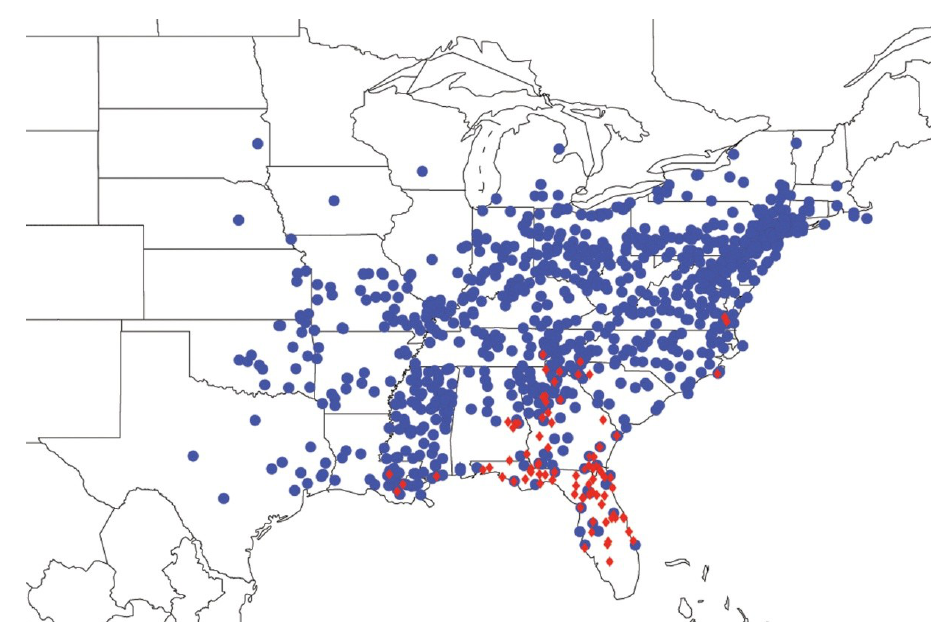
Figure 10. Distribution of Tibicen tibicen tibicen (blue circles) and T. tibicen australis (red